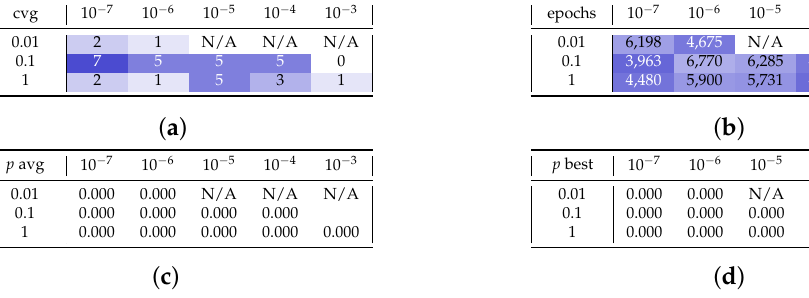
over converging runs).